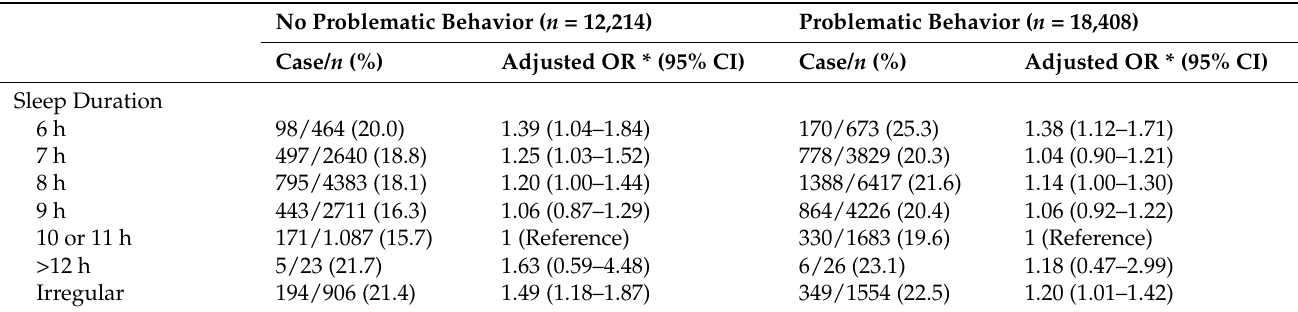
Table 4. Logistic regression analysis to investigate the relationship between sleep duration and injury stratified by presence or absence of problematic behavior at eight years